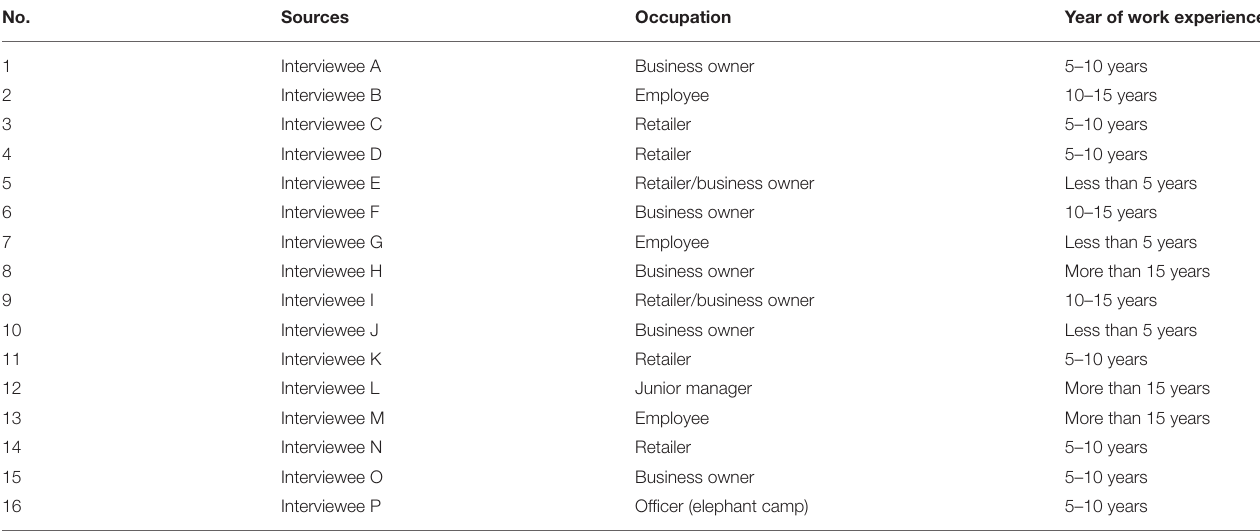
TABLE 1 | Interviewee information, occupation and year of work